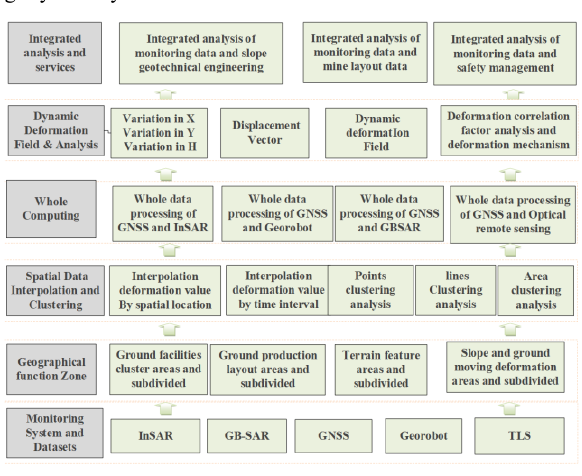
Figure 9. Computing Theory Framework of Geosensor